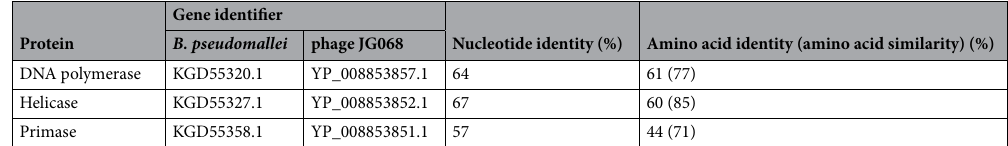
Table 4. Homology between genes adjacent to Bsp-lig in B. pseudomallei BES and those in bacteriophage JG068.